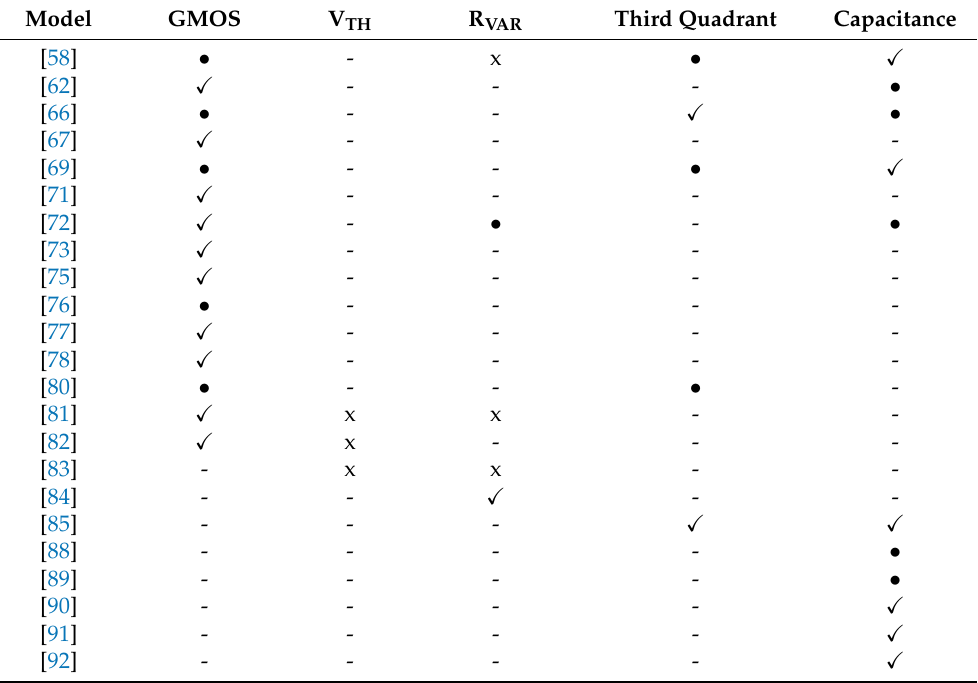
Table 1. GaN modelling: usability of equations adopted in MOSFET models. Legend: (cid:88) valid; • adaptable; x useless; - not